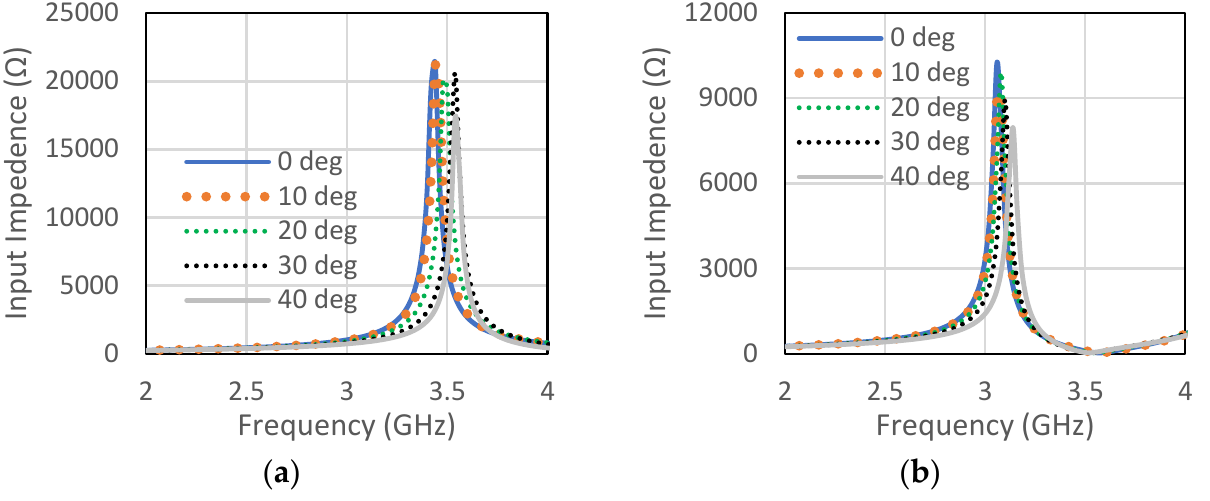
Figure 6. The magnitude of the input impedance of the ( a ) circular patch and ( b ) circular patch with a ring.